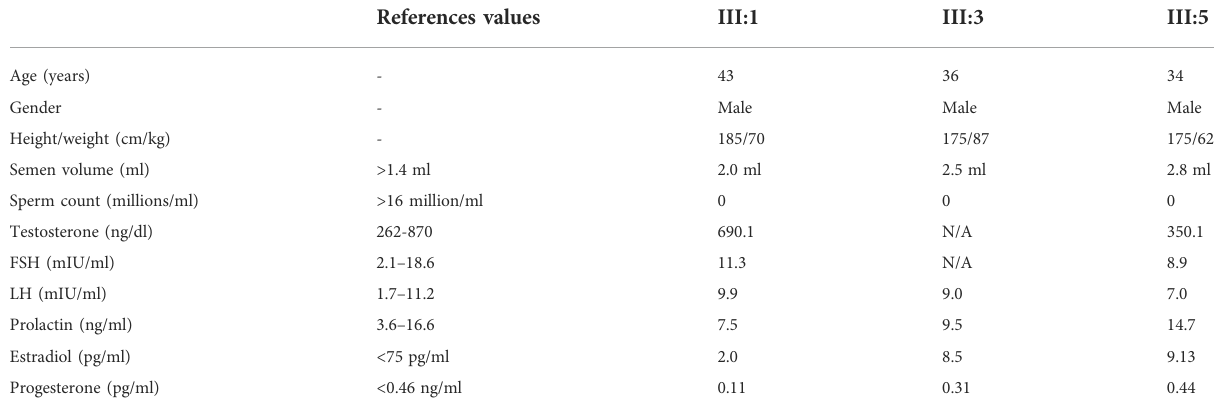
TABLE 1 Clinical Investigations of patients harboring novel homozygous DND1 variant.